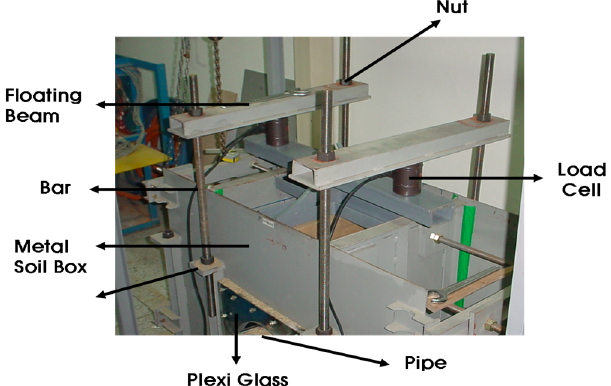
Figure 7. Small-scale